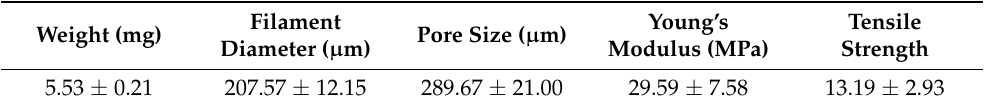
Table 1. The average weight, filament diameter, pore size, Young’s modulus, and tensile stress of the industrial polylactic acid (PLA) three-dimensional scaffold ( n = 3).